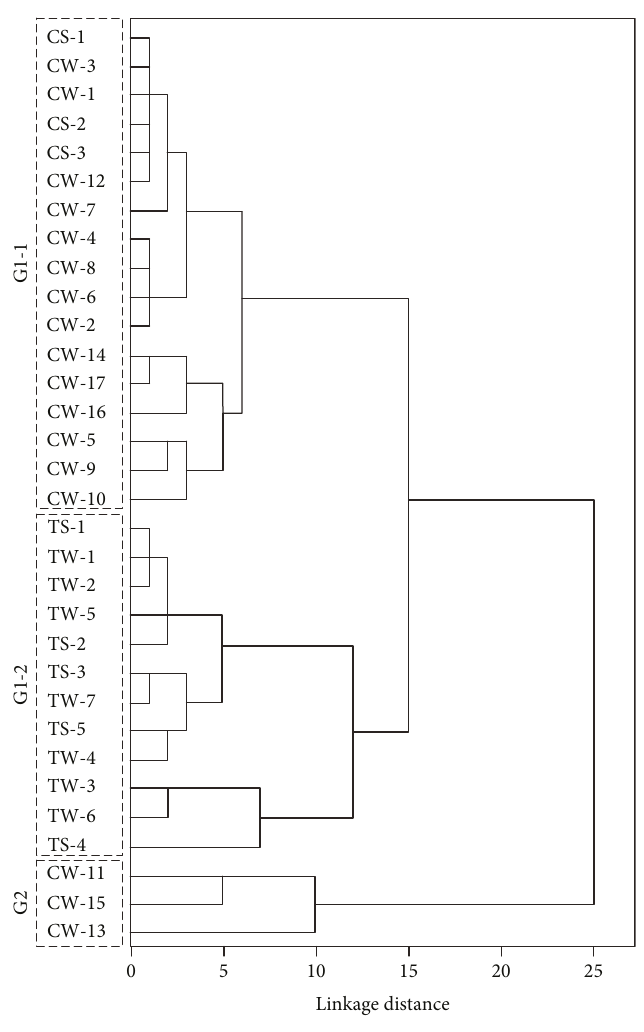
Figure 3: Cluster analysis of water samples of the